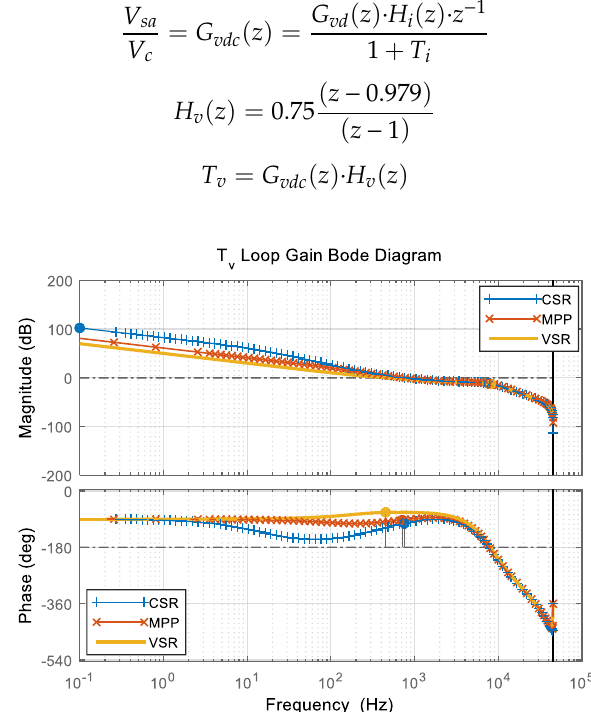
Figure 11. Board diagram of voltage loop gain of two-loop control.